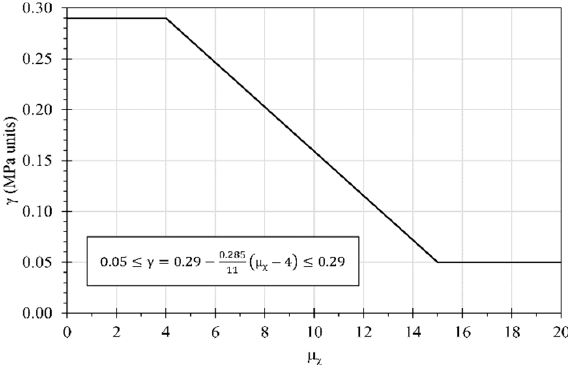
Figure 9. The factor γ after Kowalsky and Priestley [30] (in Equation (14)).